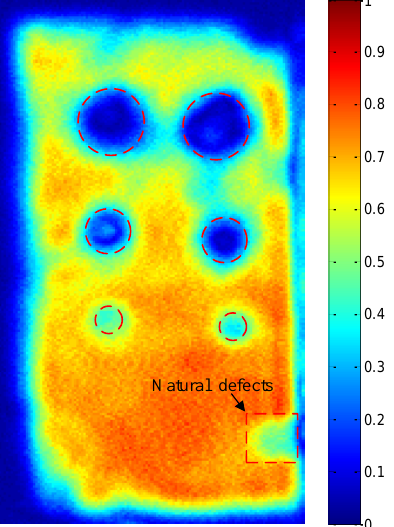
Figure 23. The C-scan results of the lithium-ion battery.